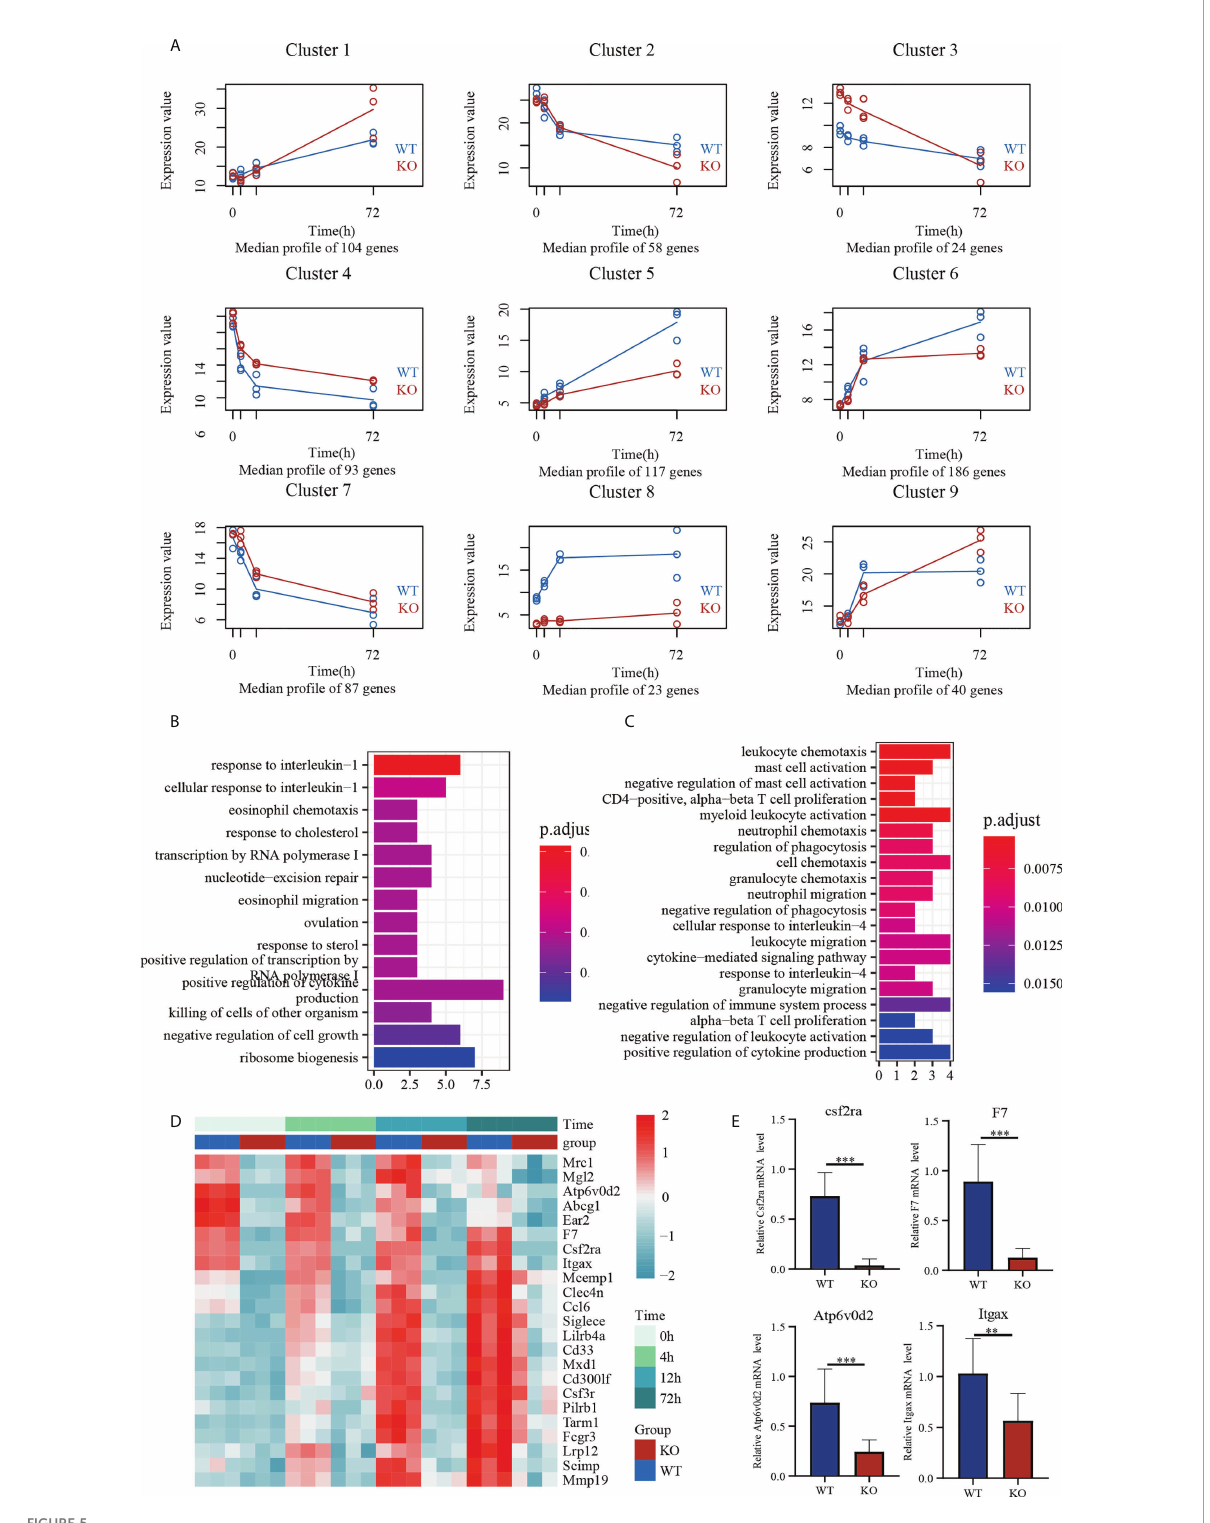
FIGURE 5 Temporal transcriptome analysis of lung tissues in Csf2ra KO mice and WT mice. (A) The nine clusters identi fi ed by the maSigPro algorithm for the selected genes. (B) Analysis of GO biological processes in Cluster 5. (C) Analysis of GO biological processes in Cluster 8. (D) Heat maps showing expression levels of genes in Cluster 8 in each group. (E) RT-qPCR veri fi cation of genes with consistently low expression in Csf2ra KO mice. Welch ’ s t test; **P <0.01, ***P